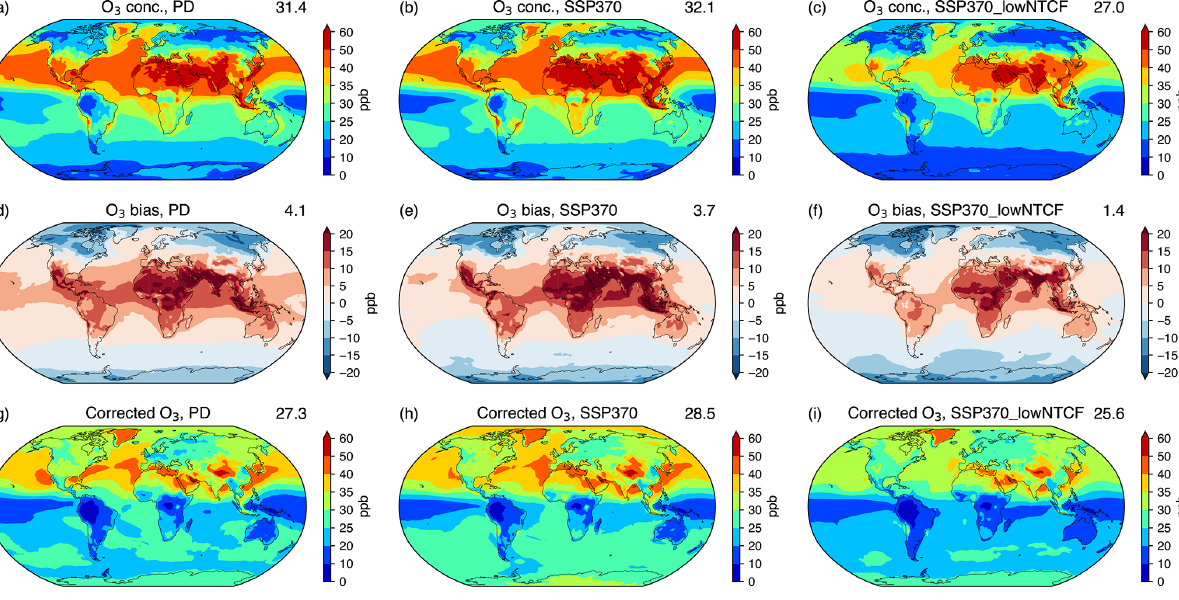
Figure 8. Annual mean surface O 3 mixing ratios (ppb) from UKESM1 simulations for (a) the present day (PD), (b) SSP3-7.0 and (c) SSP3-7.0-lowNTCF. The corresponding surface O 3 biases predicted with the deep learning model are shown in panels (d) – (f) and corrected surface O 3 mixing ratios are shown in panels (g) – (i) . Annual global mean mixing ratios are shown in the top right of each